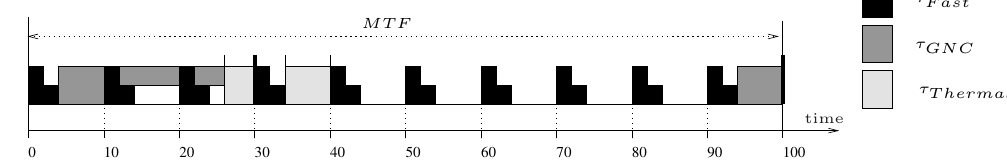
Figure 12 Scheduling result for the two-mode example of Figure 6 on a single-processor architecture.